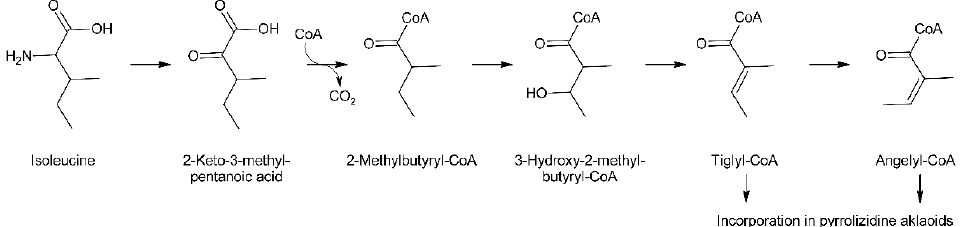
Figure 11. Biosynthesis of tiglic and angelic acid. L -Isoleucine is desaminated and the obtained ketocarboxylic acid decarboxylated to 2-methylbutyric acid, which is likely accompanied by linking with coenzyme A to yield 2-methylbutyryl-CoA. This intermediate is hydroxylated and subsequently dehydrated to form tiglyl-CoA, which can be isomerized to angelyl-CoA. The activated tiglic and angelic acid residues are finally transferred to necine bases and coenzyme A is released.